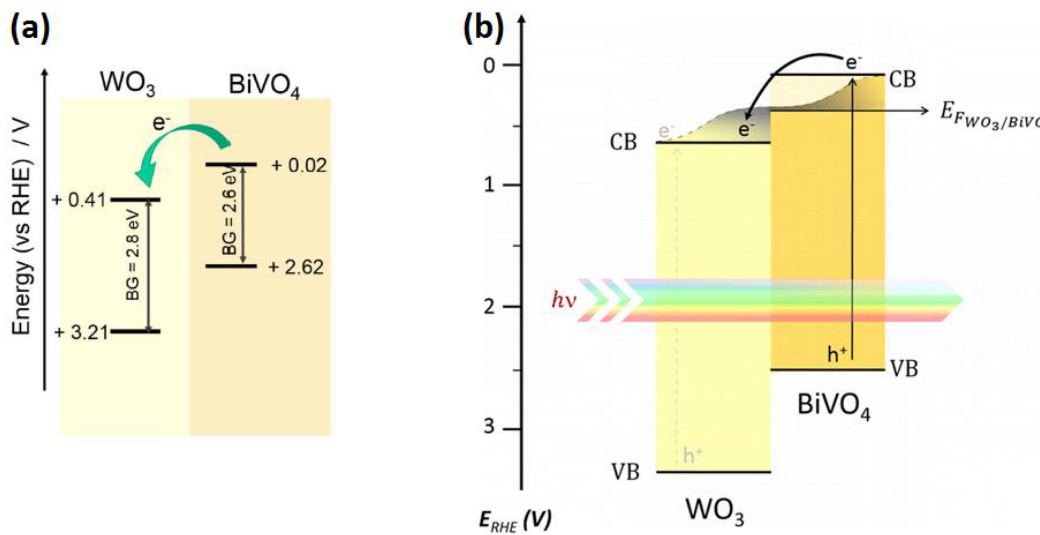
Figure 11. ( a ) Diagram of the band edge positions of pure WO 3 and BiVO 4 and ( b ) for a WO 3 –BiVO 4 composite under solar irradiation. Reproduced from [137], with permission from American Chemical Society,